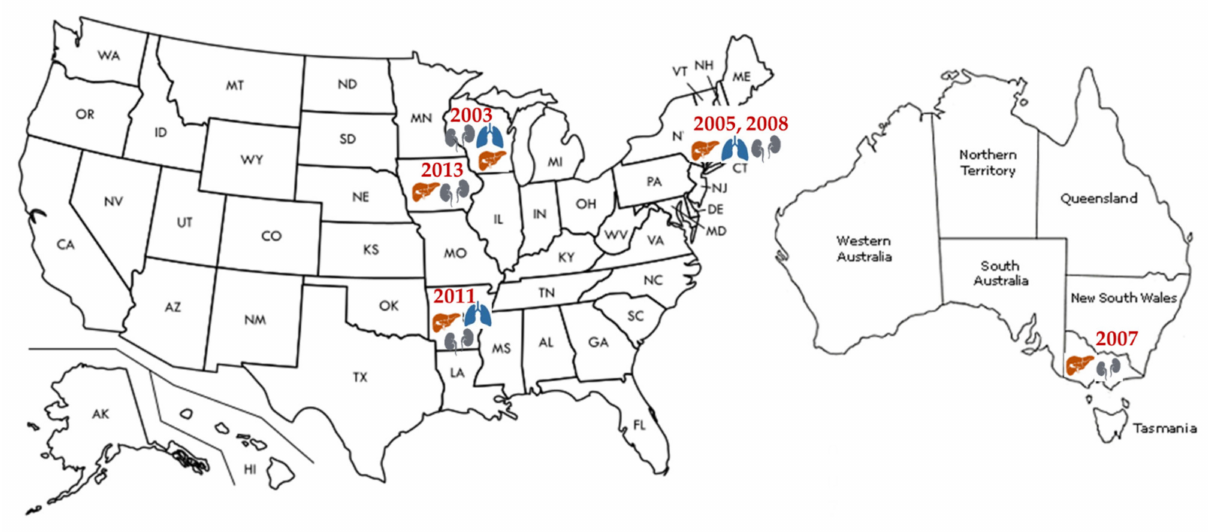
Figure 4. Transplantation associated LCMV